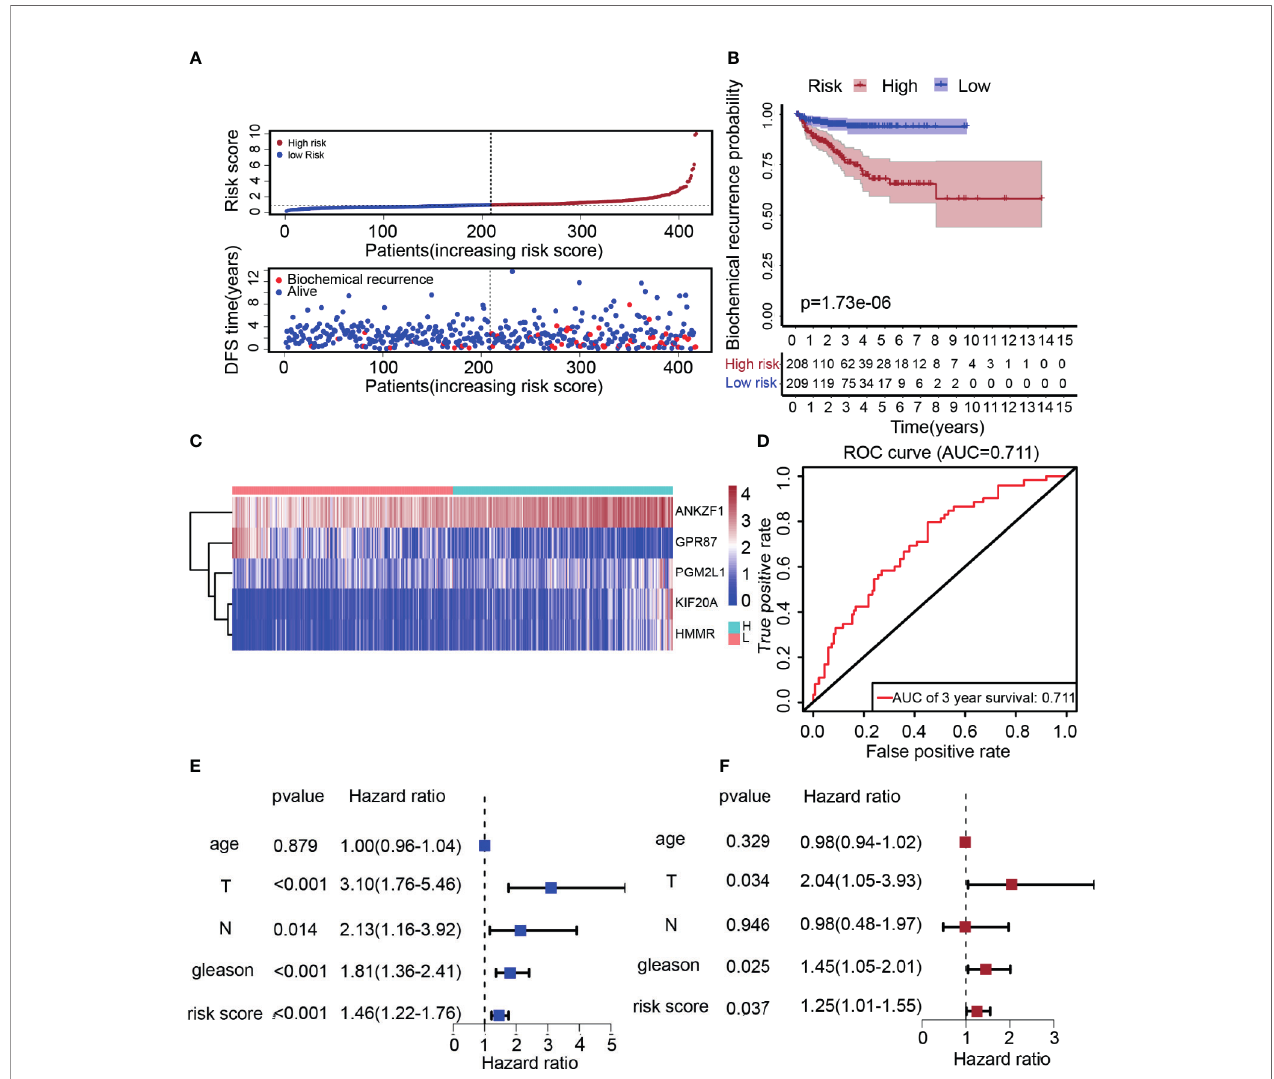
FIGURE 4 | Construction of a risk score model based on fi ve glycolysis-related genes. (A) The distribution of the fi ve-mRNA risk score and survival status for each patient. (B) Kaplan – Meier curve of survival time in high-risk and low-risk group. (C) Expression of fi ve glycolytic genes in the high-risk group and low-risk group based on TCGA. (D) ROC curves of the glycolysis-related signature for prediction of DFS of patients with PCa (AUC = 0.711). (E, F) Univariate and multivariate Cox regression analysis of clinical information (Age, T stage, N stage, Gleason score, and risk